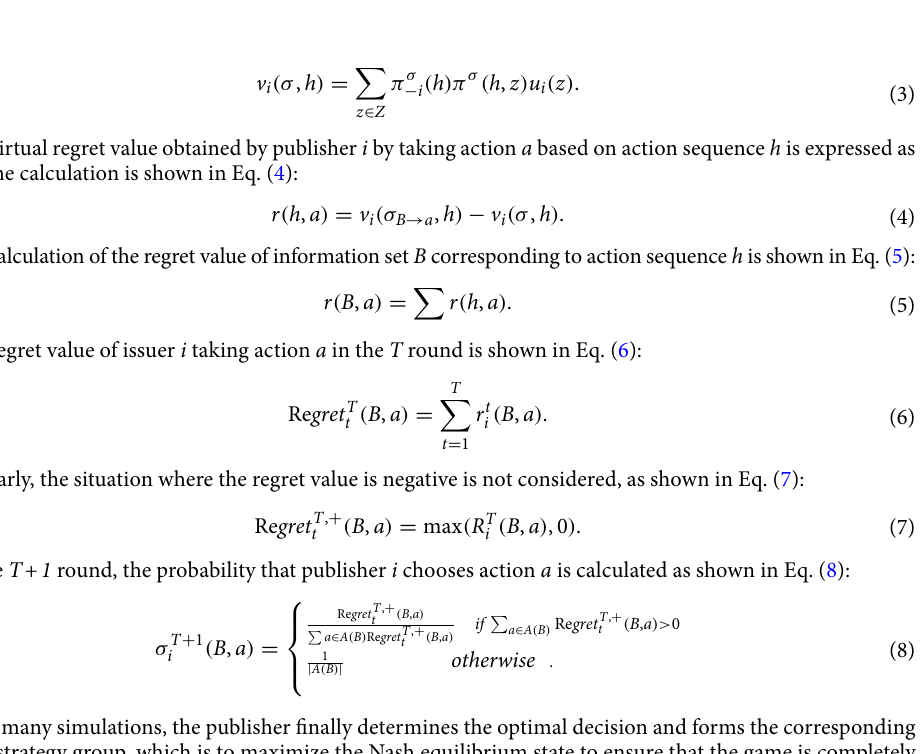
Figure 3. Logic diagram for initializing the smart